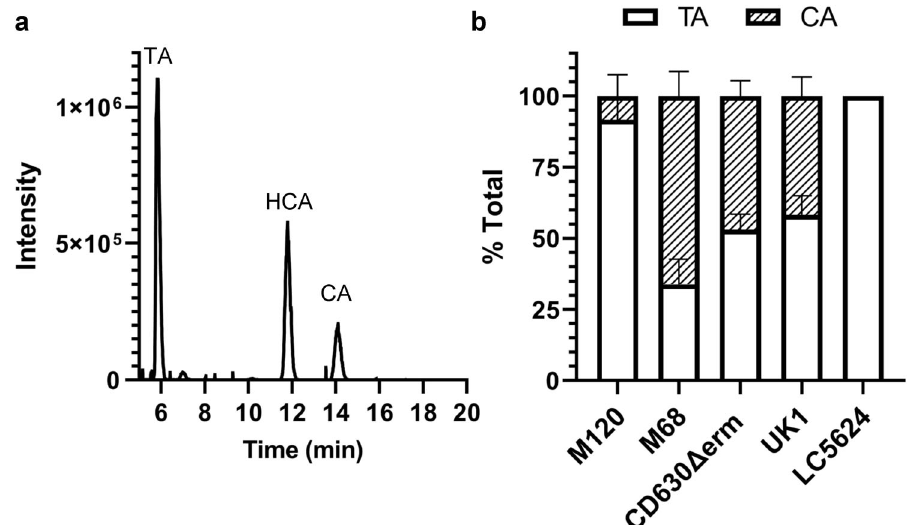
Fig. 2 Several C. dif fi cile strains can deconjugate taurocholate. a C. dif fi cile CD630 Δ erm was grown in rich medium supplemented with 1 mM taurocholate (TA) for 24 h. The bile salts were then analyzed by HPLC-coupled evaporative light scattering. Peak retention times for each bile acid were determined by using bile acid standards (Supplementary Fig. 1). b Deconjugation of TA by C. dif fi cile strains M120, M68, CD630 Δ erm, UK1, and LC5624 were determined as in ( a ). Values were calculated by measuring the peak areas for TA and CA and expressed as a percentage of the total input. HDCA was included as an internal standard. Values shown are the average of three different independent experiments, and error bars represent the standard error of the mean.